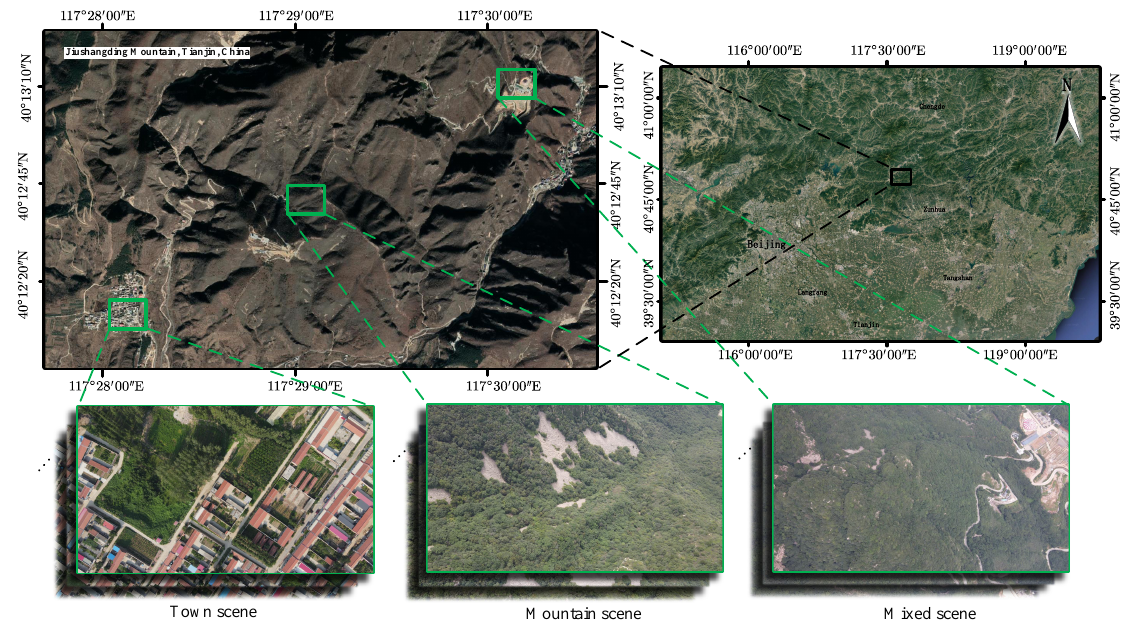
Figure 15. Examples of satellite images and low altitude aerial images of the town, mountain and the mixed zone scene. Table 3. Detailed statistics of aerial datasets and results point cloud number of our method. Image